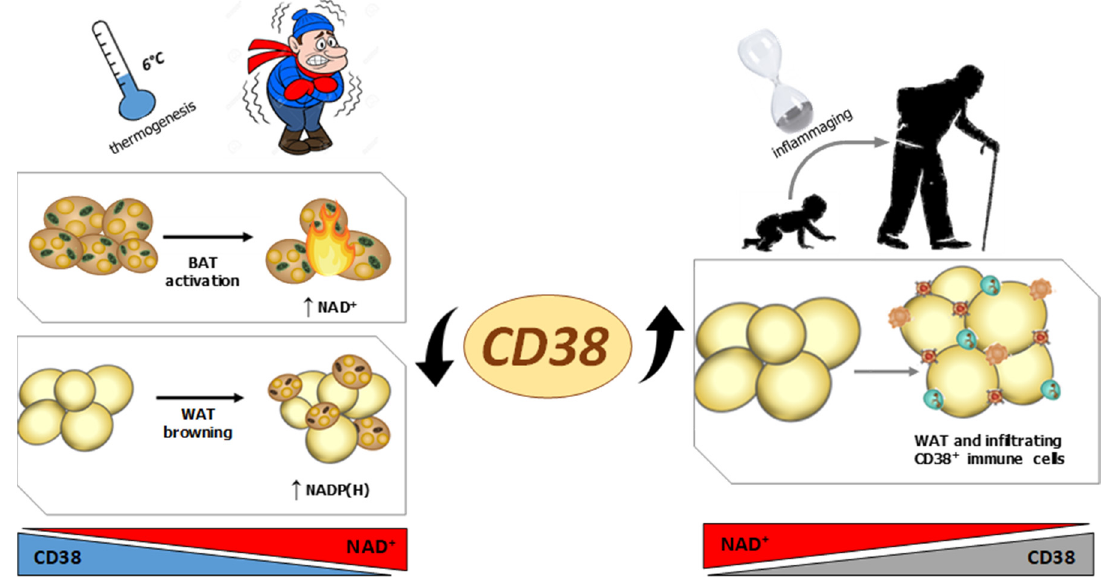
Figure 2. Regulation of CD38 expression and NAD(P) content in adipose tissue during thermogenesis or during inflammaging. CD38 expression is regulated in opposite directions during thermogenesis or during inflammaging. In thermogenesis, CD38 downregulation is paralleled by an increase in NAD + levels in BAT, and by an increase in NADPH in WAT. During inflammaging, CD38 upregulation is followed by a NAD + decrease in WAT.